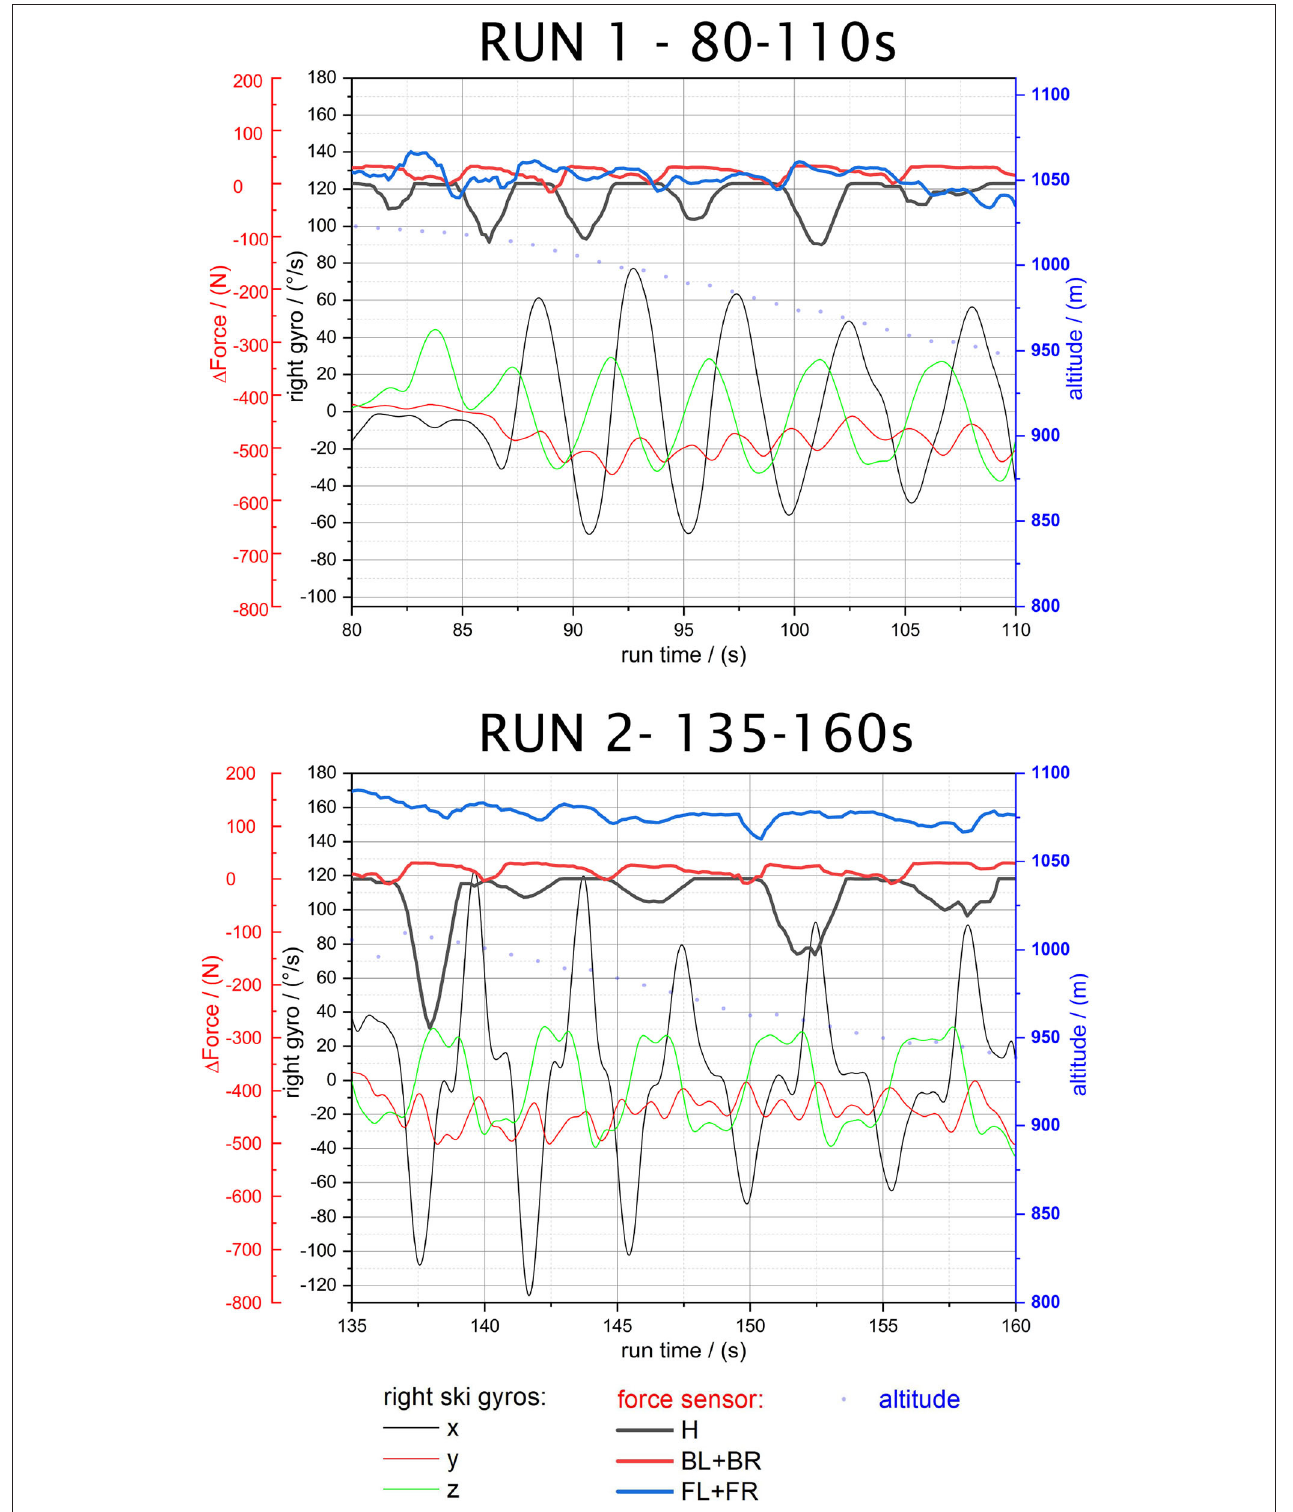
FIGURE 6 | Run 1—80–110 s and Run 2—135–160 s.